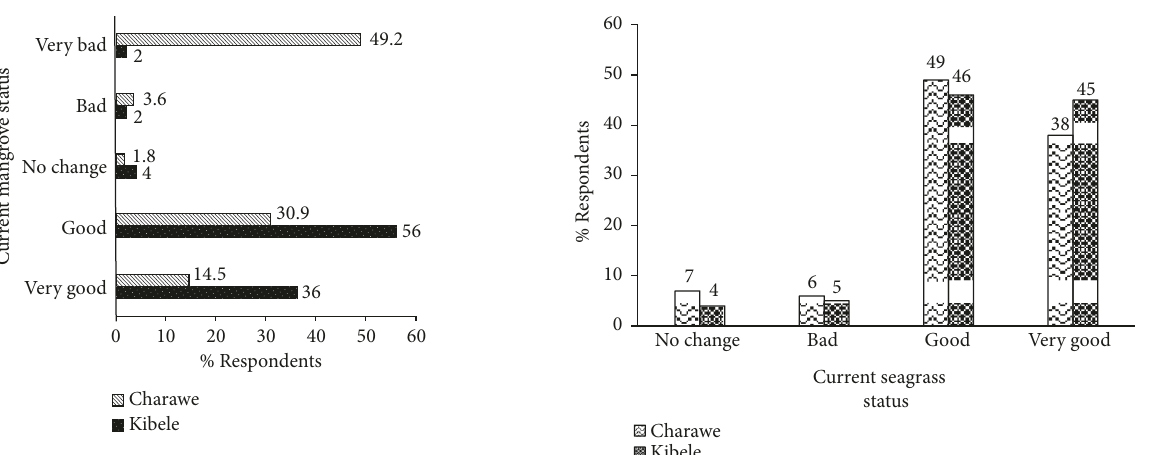
Figure 3: Perception on the current mangrove status in Charawe and Kibele as compared to the situation 10 years ago. Figure 4: Perception on current status of seagrass beds in Charawe and Kibele as compared to the situation 10 years